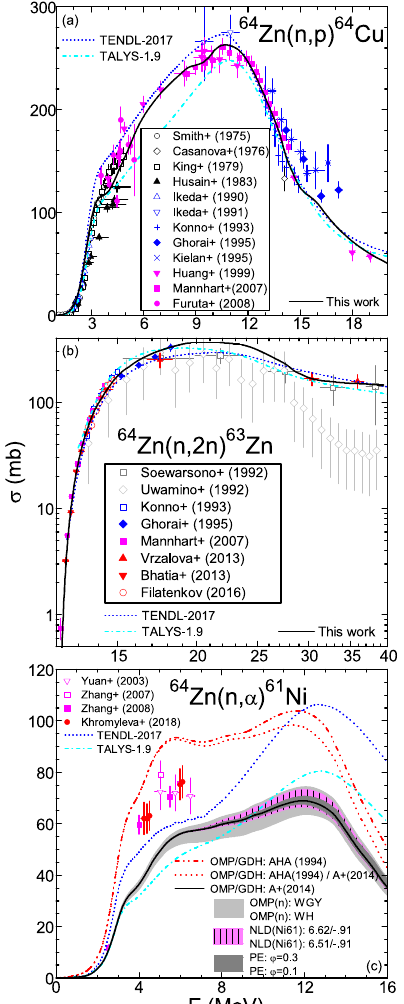
Figure 5. As Fig. 2 but for 64 Zn( n , x ) reactions, except additional TALYS-1.9 results (short dash-dotted), and uncertainty bands for neutron OMP [23, 24] (light gray), NLD (magenta), and PE (gray) e ff ects on the results obtained by using the OMP [3].